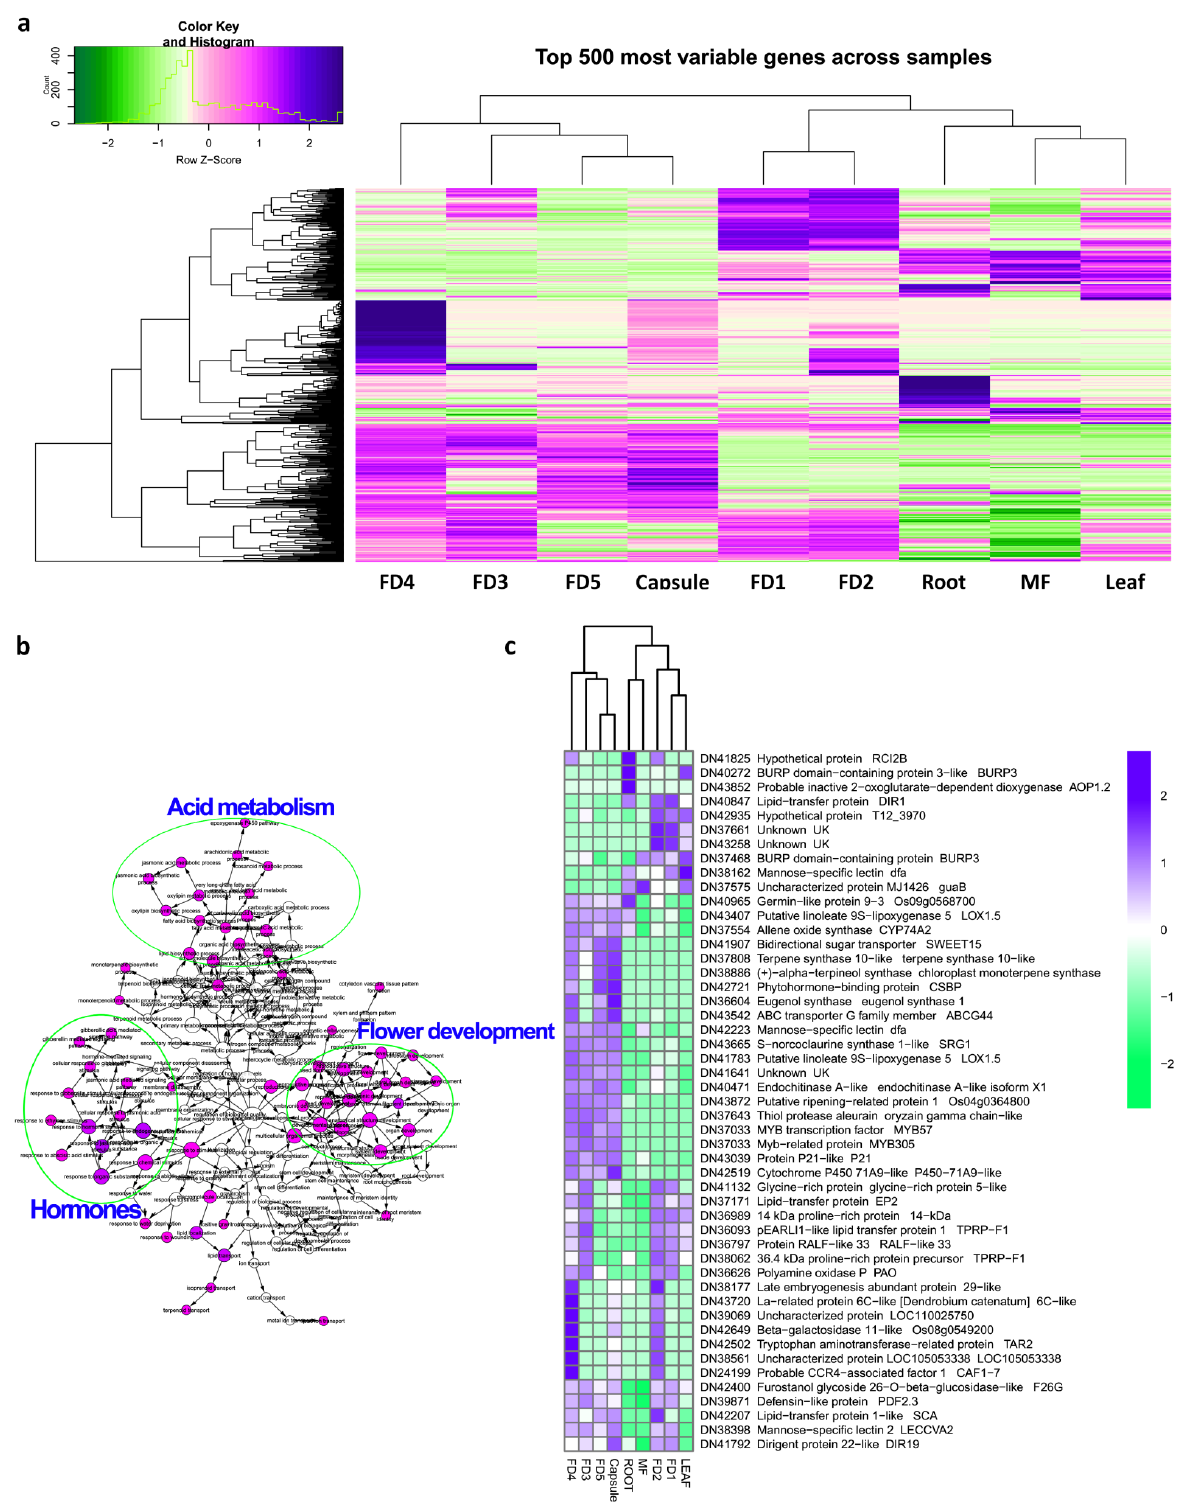
Figure 5. ( a ): Heatmap of the top 500 differentially expressed genes; ( b ):clustering of the top 50 DEGs by Cytoscape; ( c ):heatmap with gene names of the top 45 DEGs.